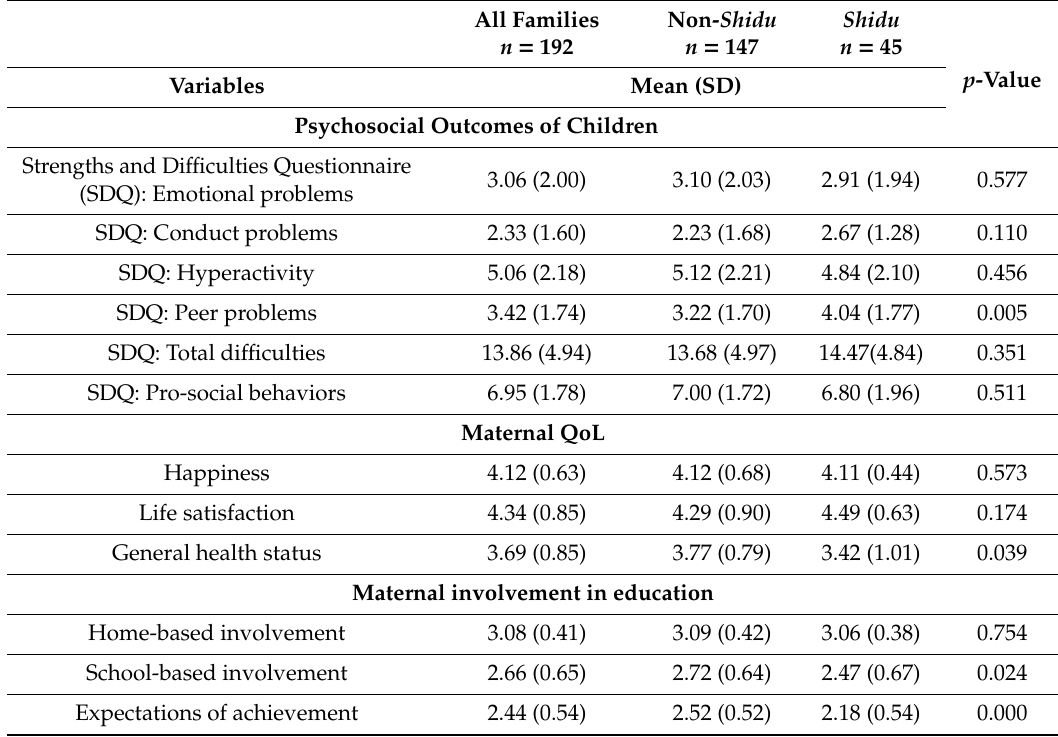
Table 2. Psychosocial outcomes of children, maternal quality of life (QoL), and involvement in education. ( n = 192).